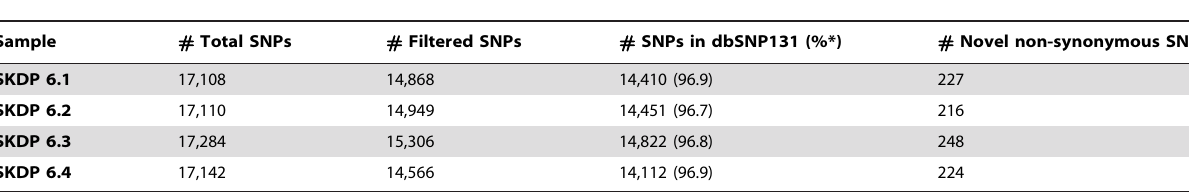
Table 1. SNPs detected in four exomes.